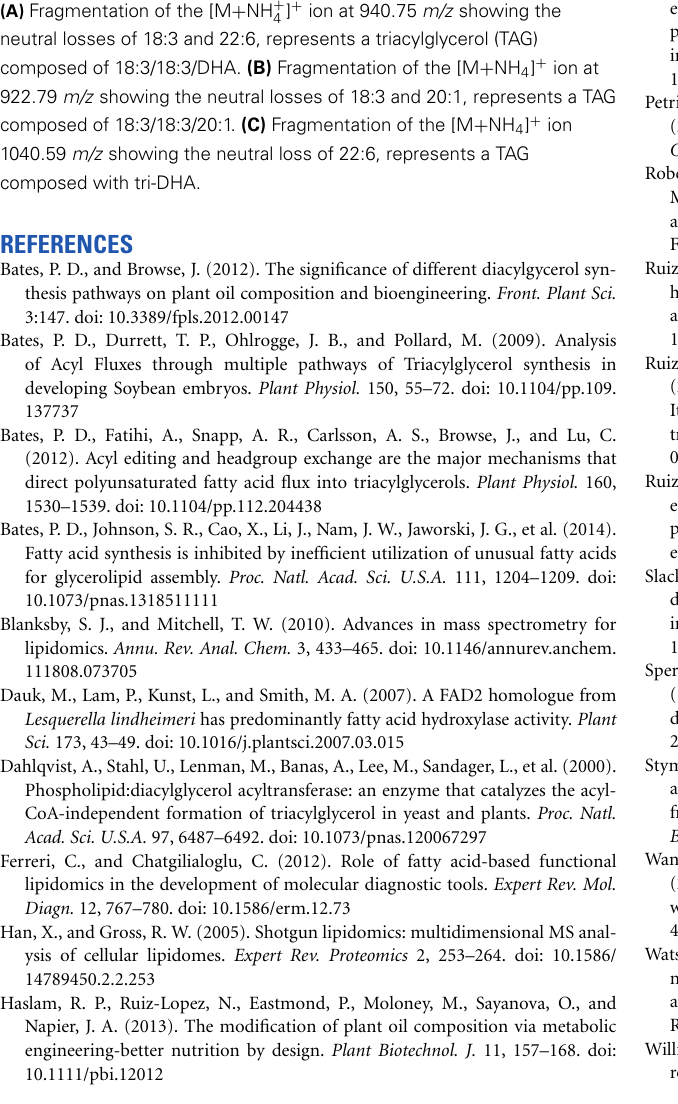
Figure S1 | MS/MS analysis of phosphotidylcholine (PC) precursor at m/z 878.6 with a PC head group ion of m/z 184.2. Y axis represents the response of ion scan. The low abundant fragment at m/z 568.3 is due to the neutral loss of 22:6, thus confirming the identity as PC 22:6/22:6. Figure S2 | Low abundance phosphatidylserine (PS) pool in the developing and the mature Arabidopsis seeds. The PS are annotated similarly to PC. Data are shown as the mean of triplicate analysis with the error bars representing the standard deviations. Figure S3 | The abundances of long-chain polyunsaturated fatty acids (LC-PUFA) containing diacylglecerol (DAG) in the WT and GA7 Arabidopsis seeds. Data are shown as the mean of triplicate analysis with the error bars representing the standard deviations. Figure S4 | Product ion spectra for identification of selected lipid species. (A) Fragmentation of the [M + NH + 4 ] + ion at 940.75 m/z showing the neutral losses of 18:3 and 22:6, represents a triacylglycerol (TAG) composed of 18:3/18:3/DHA. (B) Fragmentation of the [M + NH 4 ] + ion at 922.79 m/z showing the neutral losses of 18:3 and 20:1, represents a TAG composed of 18:3/18:3/20:1. (C) Fragmentation of the [M + NH 4 ] + ion 1040.59 m/z showing the neutral loss of 22:6, represents a TAG composed with